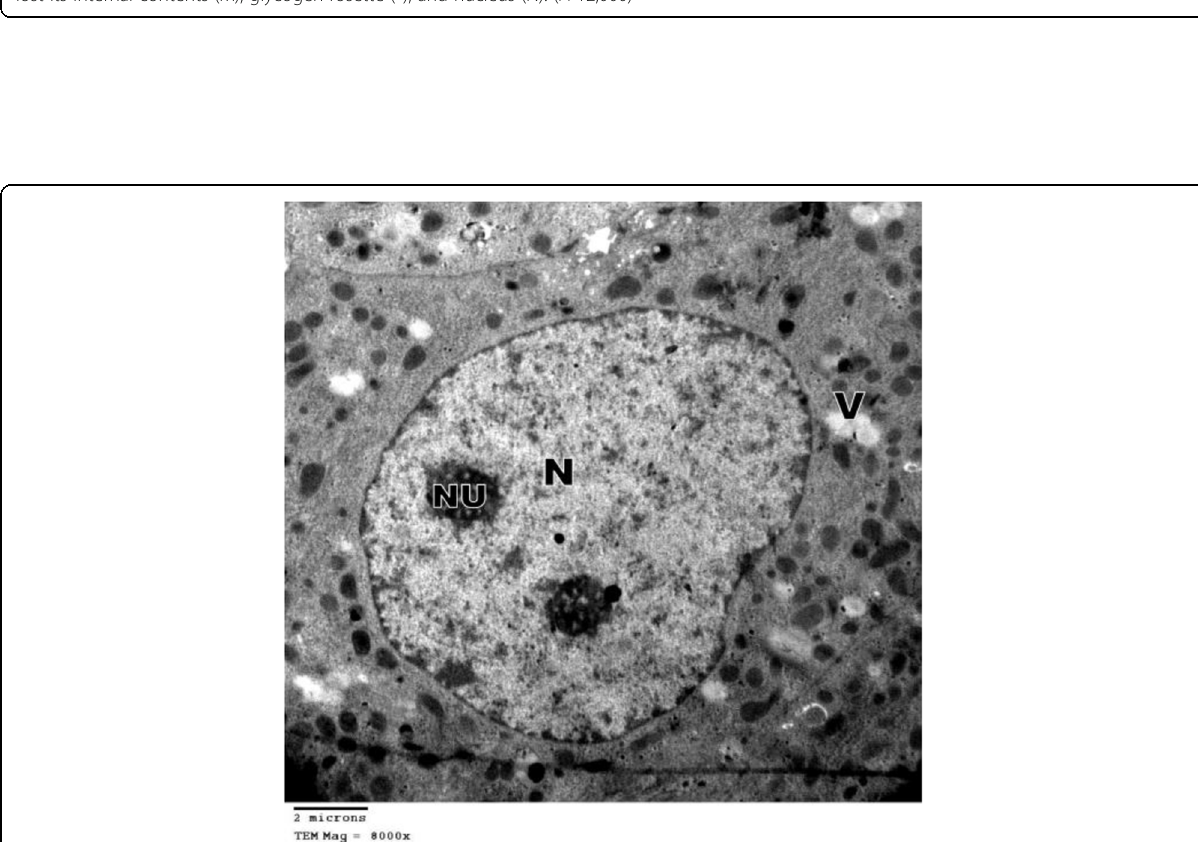
Fig. 23 An electron micrograph of a hepatocyte of treated mouse with Adamine (20 mg/kg b.wt.) for 10 days illustrating swollen mitochondria lost its internal contents (M), glycogen rosette (*), and nucleus (N). (× 12,000)